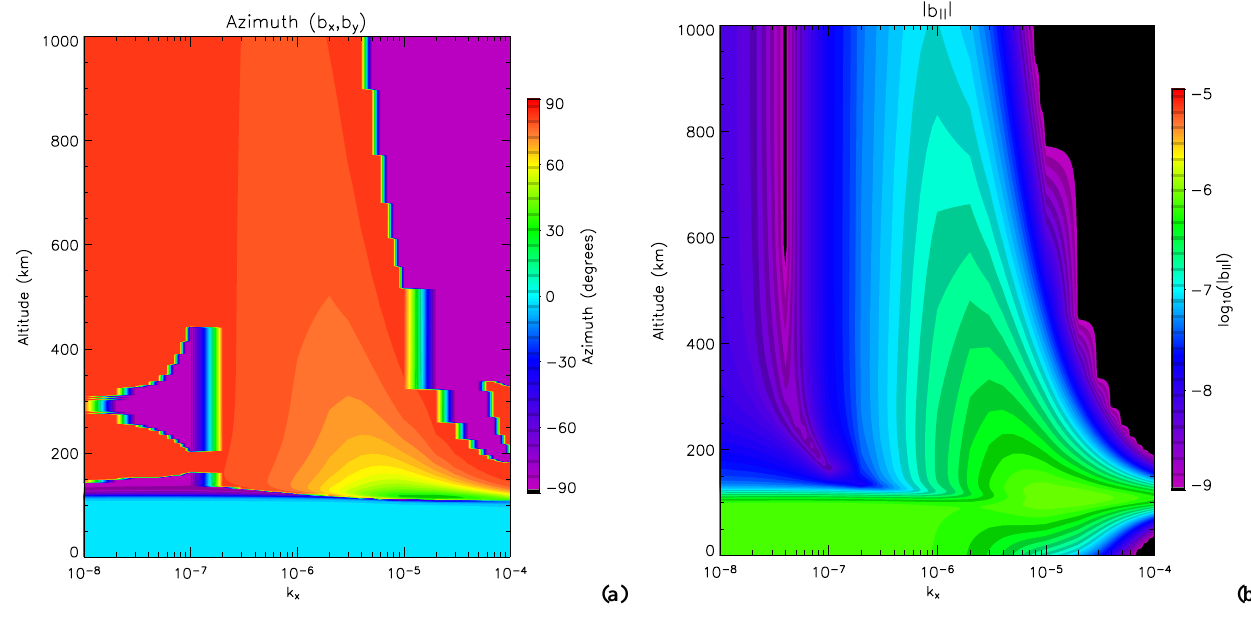
Fig. 9. The (a) polarisation azimuth computed from the b x and b y ULF wave fields and (b) the field aligned component of the ULF wave field for a frequency of 16mHz, dip angle I = 70 ◦ for solar maximum parameters. The east-west wavenumber, k y = 1 × 10 − 10 m − 1 .